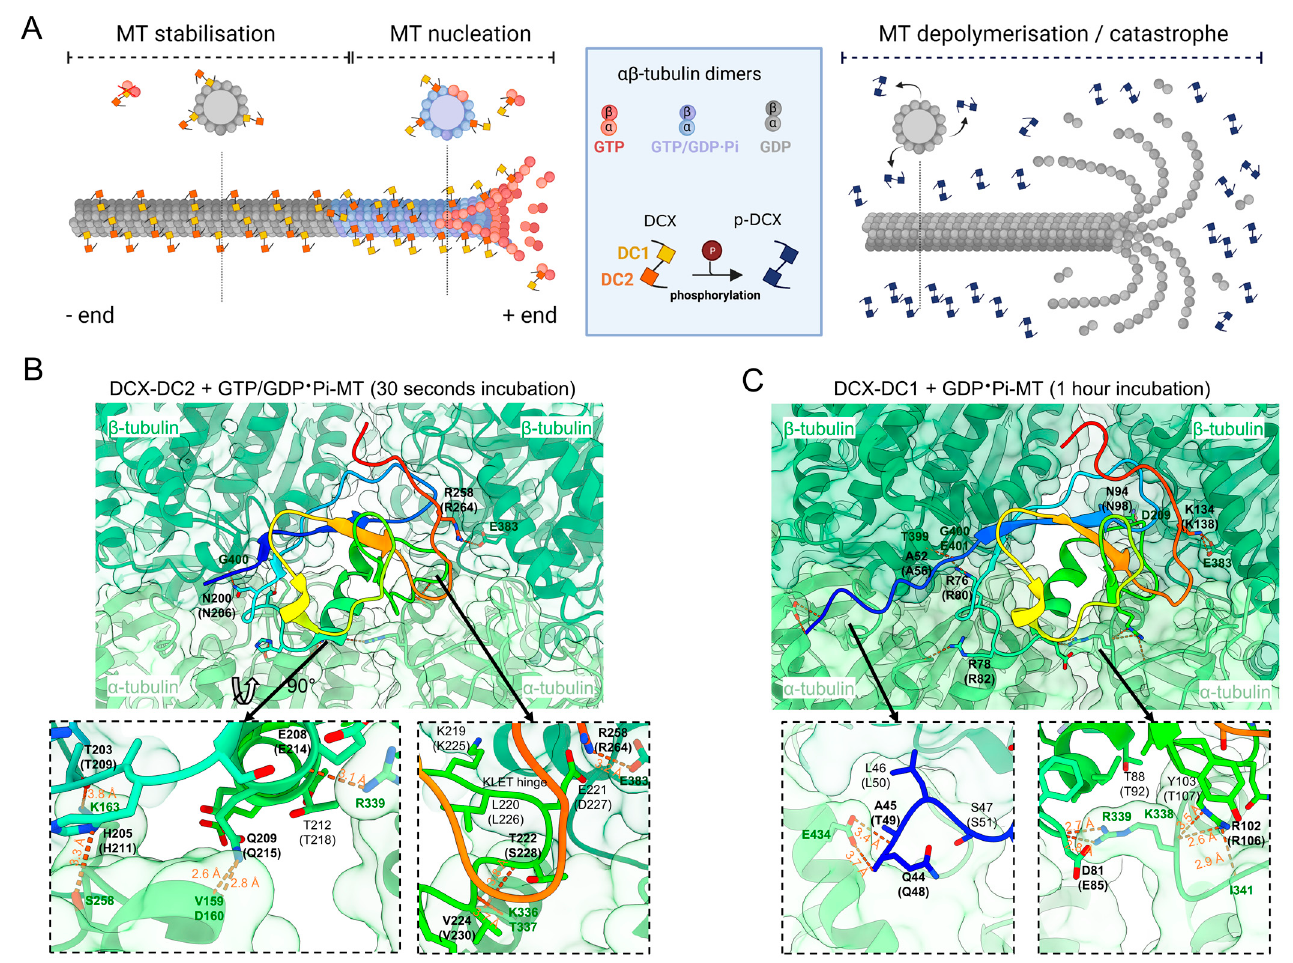
Figure 2. Structural basis of microtubule (MT) stabilization and polymerization by doublecortin protein (DCX): ( A ) schematic depiction of DCX domain functions. The more flexible doublecortin 2 (DC2) domain is involved in MT nucleation and preferably binds guanosine triphosphate (GTP)- αβ tubulin at the growing plus ends of the MTs. The more rigid DC1 domain binds guanosine diphosphate (GDP)- αβ tubulin and stabilizes MTs and protects them from MT catastrophe. Upon phosphorylation, both DC domains dissociate from the MTs resulting in MT depolymerization/catastrophe; and ( B , C ) time-resolved cryo-electron microscopy (EM) structures of DCX bound to MTs (( B ) PDB ID: 6RF2/( C ) PDB ID: 6REV [73]). Each DC domain is depicted in a cartoon representation (rainbow color from N- (blue) to C-terminus (red)). DCX residues which form hydrogen bonds or salt bridges with tubulin (green) are displayed as sticks and labeled in bold with the equivalent residue in DCLK1 in parentheses. Zoom panels highlight key interfaces. Distances for hydrogen bonds are indicated (orange). Schematic generated with BioRender.com and structures rendered in UCSF ChimeraX v1.5